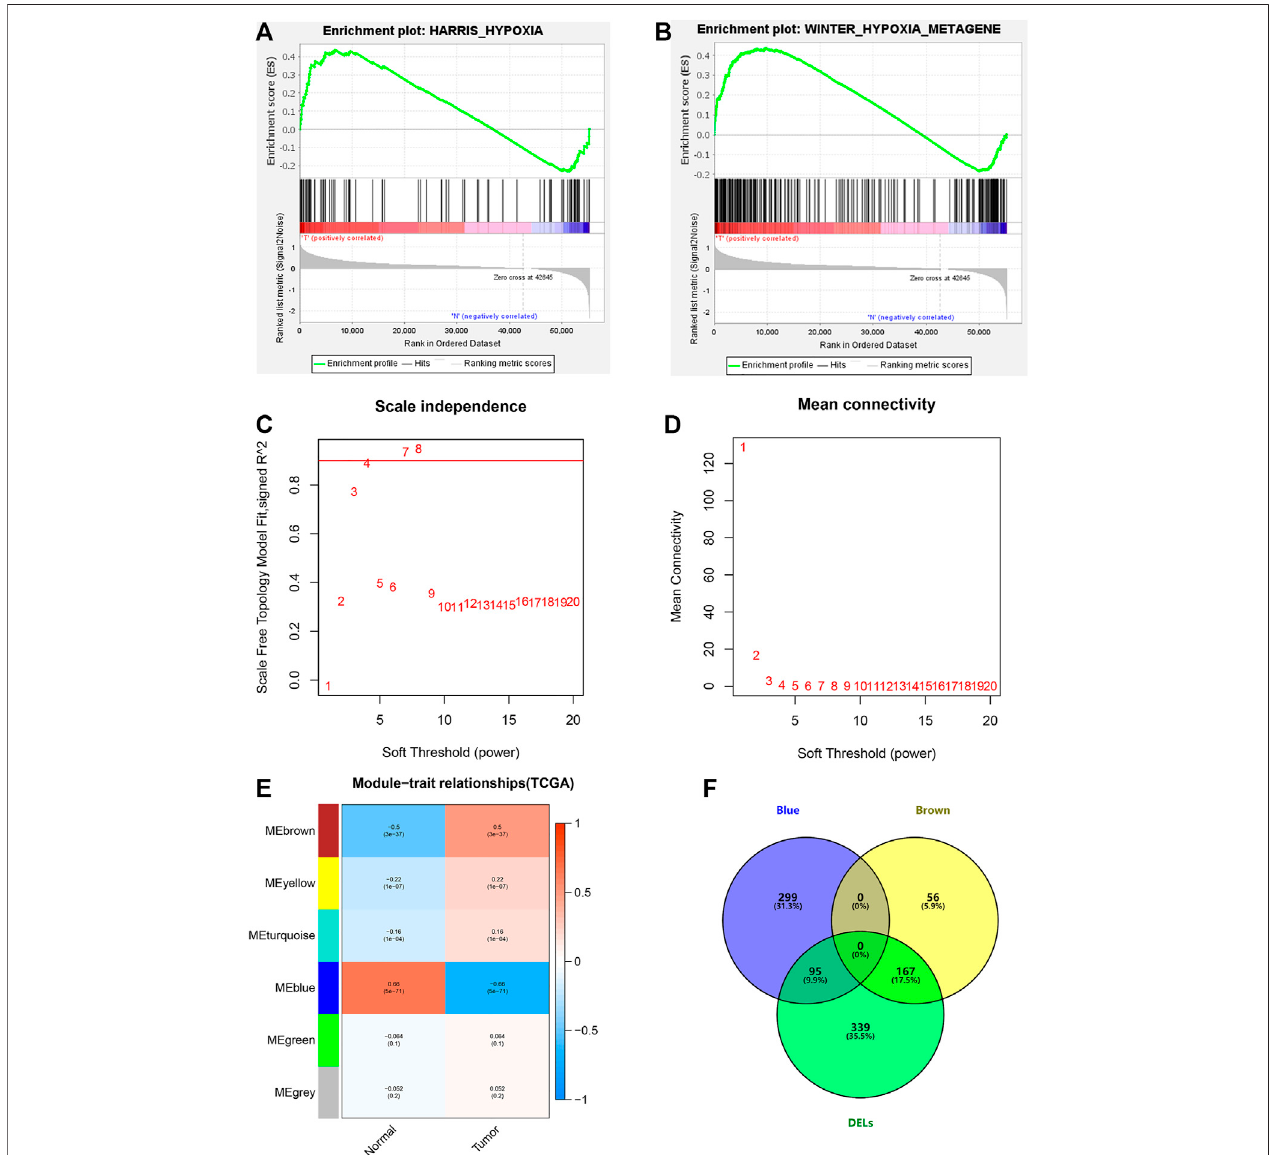
FIGURE 2 | Hypoxia-related lncRNA extraction. (A,B) GSEA analysis showing the most enriched hypoxia-related pathways. (C,D) Determination of the most suitablepowervalueforscale-freecoexpressionnetwork. (E) Brownandbluemoduleswerethemostcorrelatedwiththetumorstate. (F) Identi fi cationofcommongenes between DELs and the brown and the blue modules by overlapping